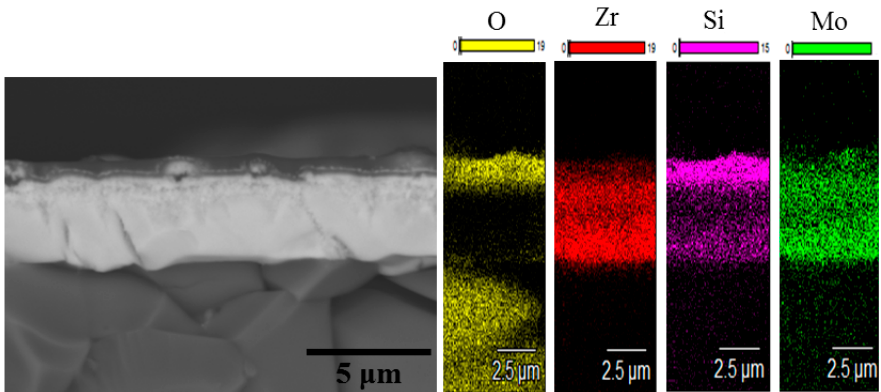
Figure 12. SEM data for the Zr-Mo-Si-B coating after exposition at 1200 °C for 10 min.